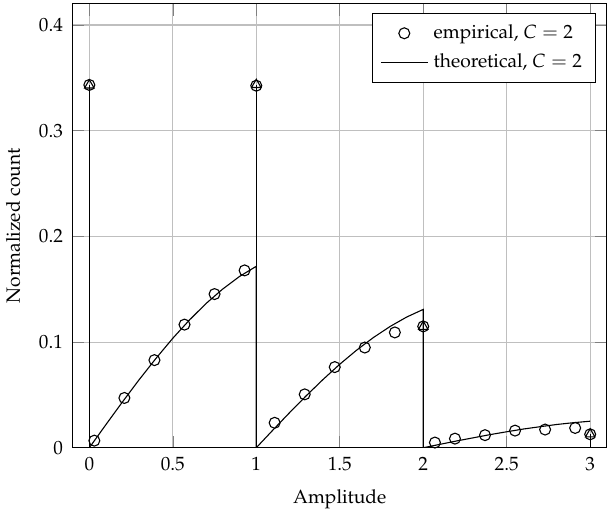
Figure 2. Probability density function of the noiseless received signal samples at the FC, for M = 3, p = 0.3, C = 2 and E =